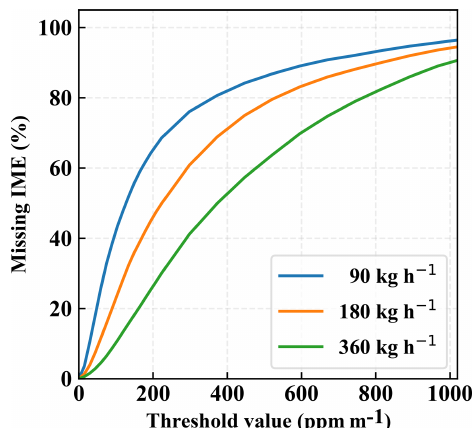
Figure 7. Missing IME, shown as a percentage, for different ppmm − 1 threshold values. Each curve corresponds to a prescribed source flux rate. The flux rates are incremented by a factor of